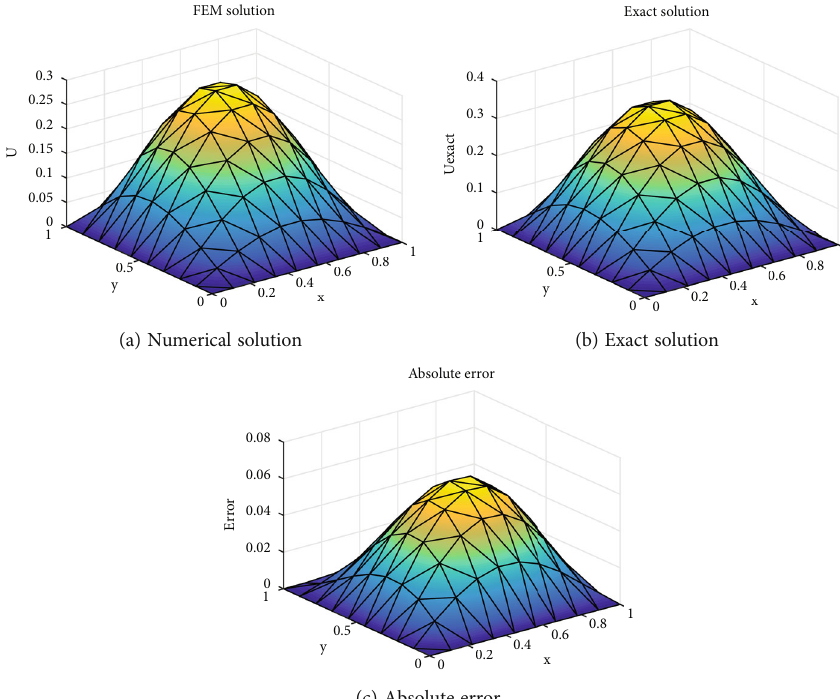
Figure 1: The numerical solution, exact solution, and absolute error between them, respectively, when the exact solution is